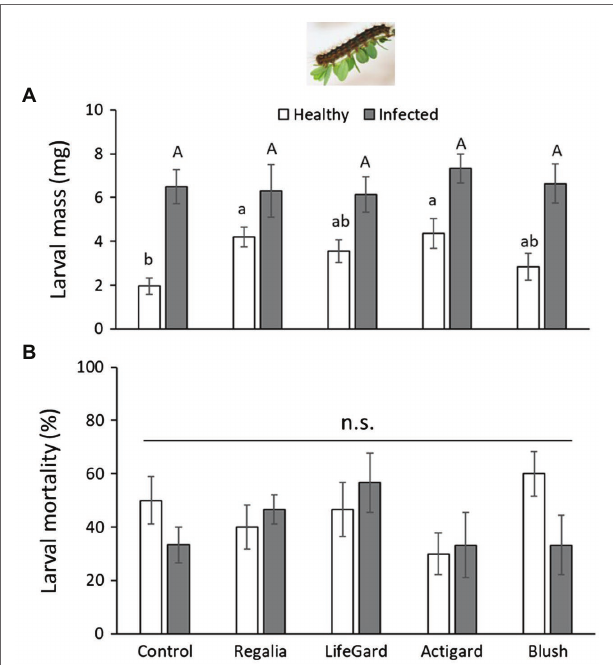
FIGURE 4 | Effects of phytoplasma infection and elicitor treatments on Lymantria dispar mass (A) and percent mortality (B) . Data are means ± SE . Different lowercase letters above bars indicate that means among elicitor treatments differ for uninfected (healthy) plants, and different uppercase letters show treatment differences for infected plants (Tukey’s HSD tests, p ≤ 0.05); n.s. = not significantly different (Tukey’s HSD tests, p > 0.05). Control plants did not receive any elicitor (i.e., treated with distilled water only). n = 10 replicates per infection/treatment